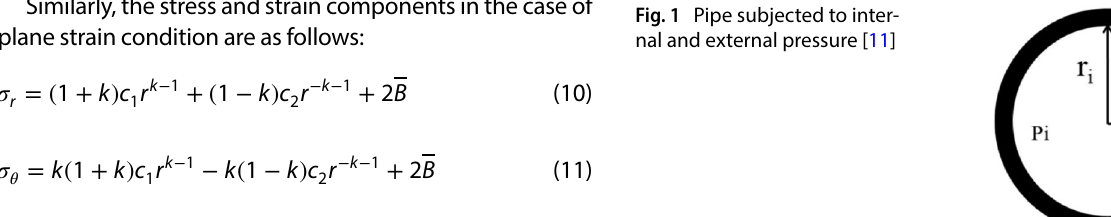
Fig. 1 Pipe subjected to inter- nal and external pressure